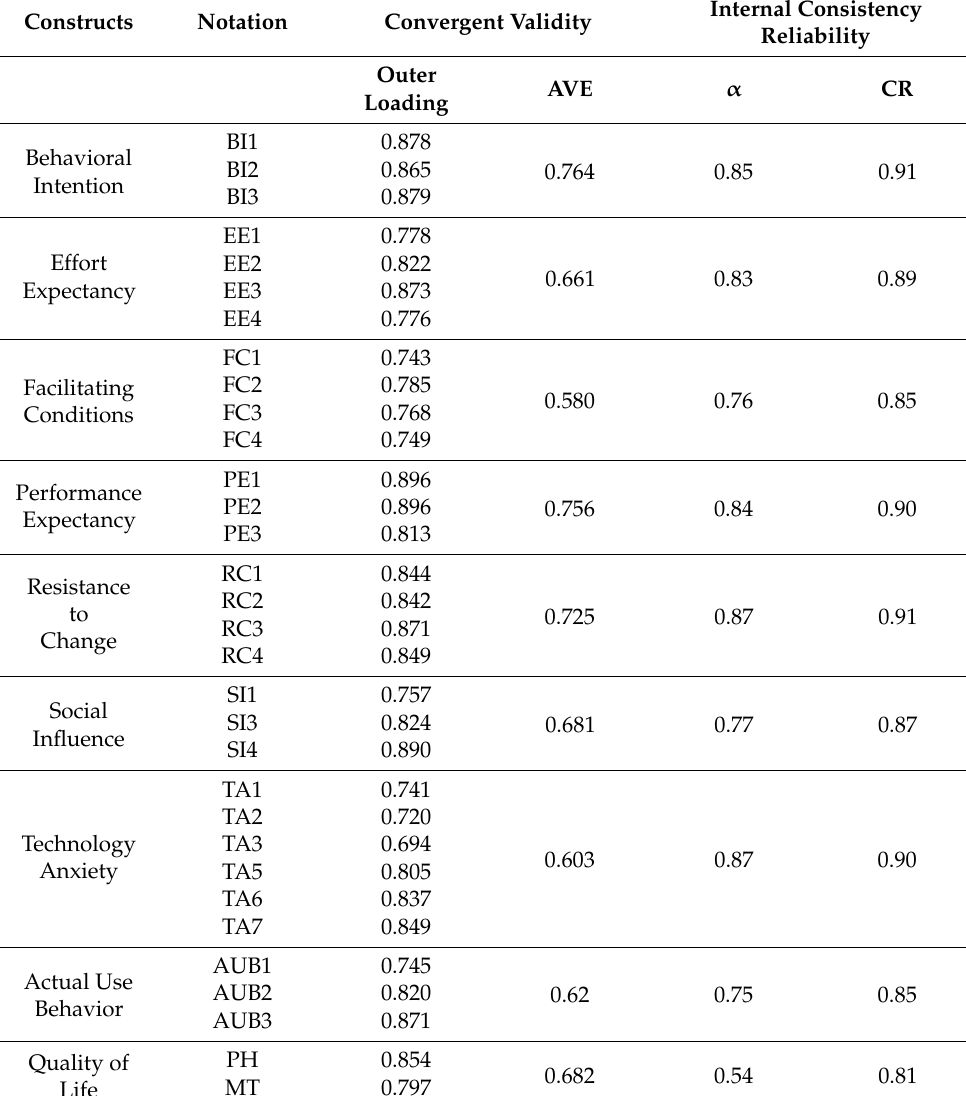
Table 3. Measurement